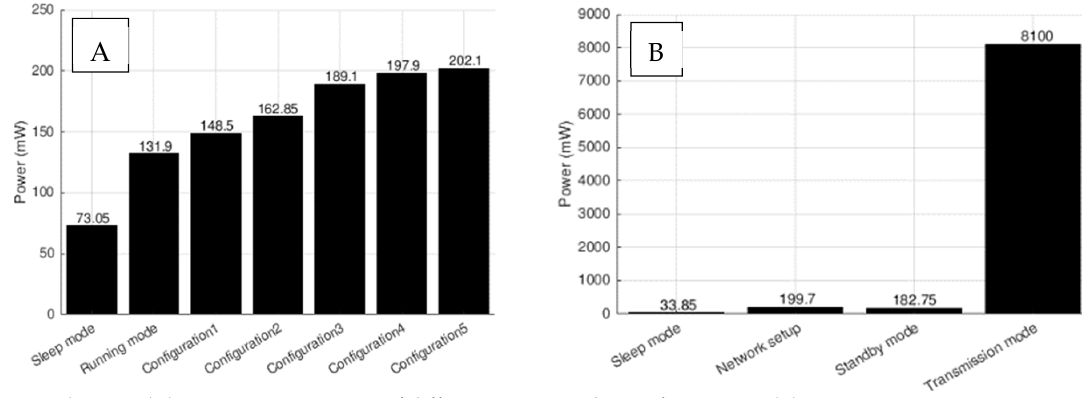
Figure 5. (A) Energy consumption of different sensor nodes configurations, (B) Energy consumption Figure 5. ( A ) Energy consumption of di ff erent sensor nodes configurations, ( B ) Energy consumption of of XBee RF module under different operating modes. XBee RF module under di ff erent operating modes.